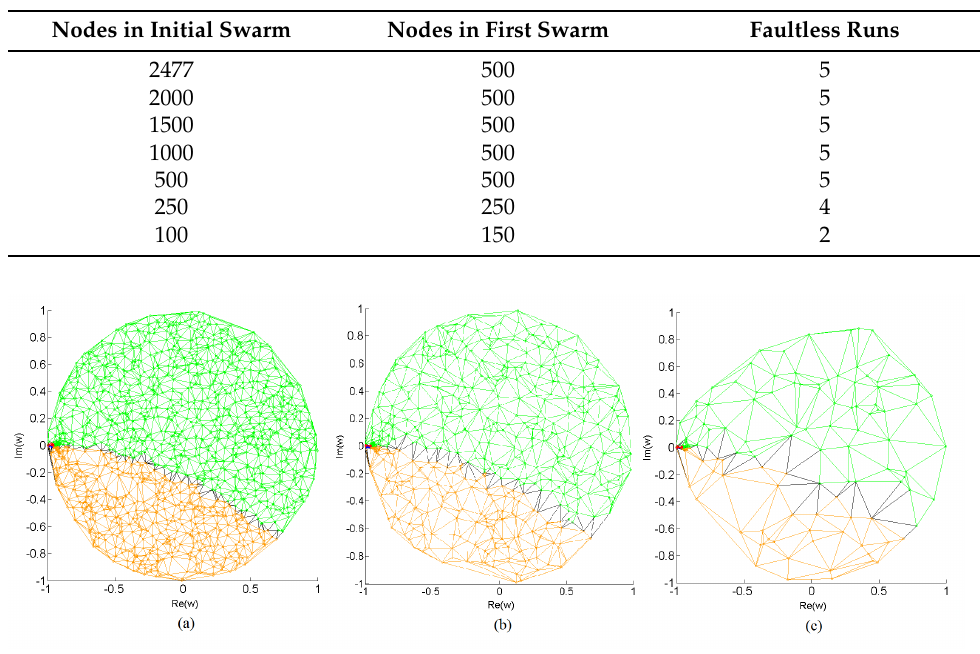
Table 5. Number of particles (nodes) in the initial and first swarms and number of runs with correctly detected digital-filter instability for the MPSO-WPA method. The stability tests are executed 5 times for each number of nodes.